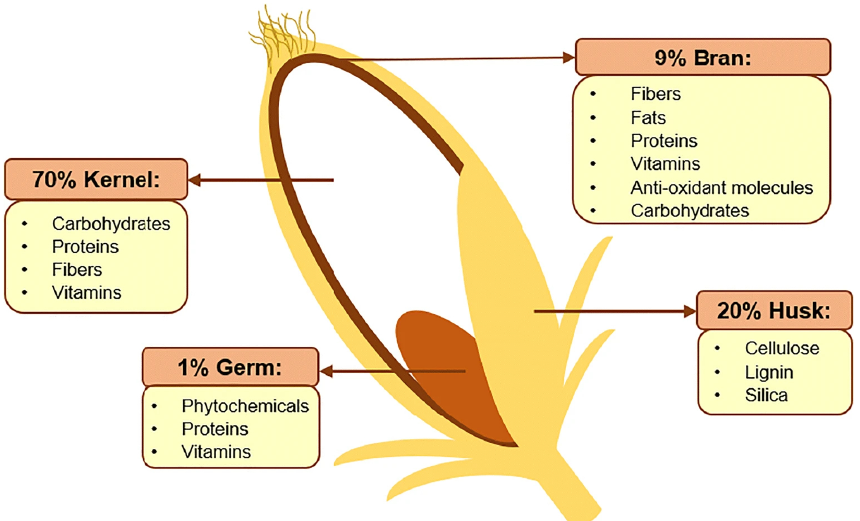
Figure 1. Schematic representation of rice before the milling process with the percentage of all its components and the main constituents. Reprinted under CC-BY 4.0 license from Fraterrigo Garofalo S., Tommasi T., & Fino, D. (2021). A short review of green extraction technologies for rice bran oil. Biomass Conv. Bioref., 11 ,